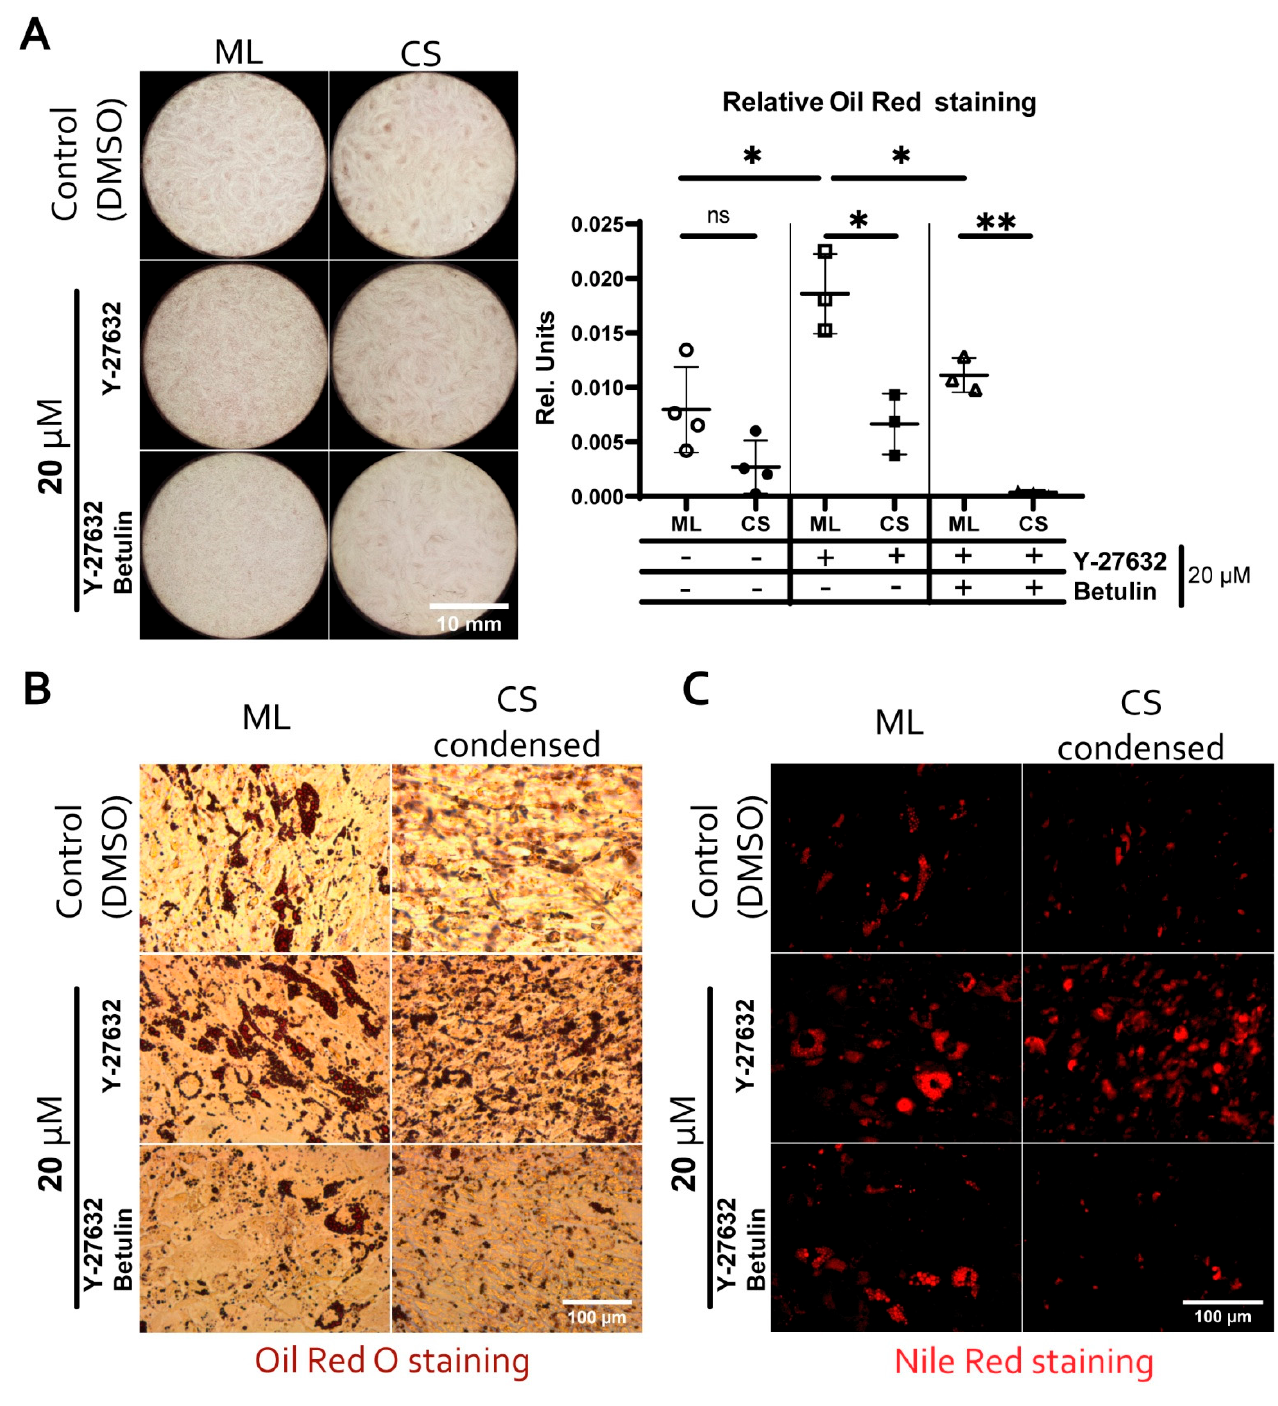
Figure 10. Lipid droplet accumulation during adipogenic differentiation is enhanced by the suppression of ROCK-1/2 pathway activity in the MSC monolayer culture but not in the total cell sheet (CS). Additional inhibition of SREBP abolishes this effect and suppresses lipid deposition in both the monolayer and whole CS. Lipid deposition in condensed areas, as well as in the monolayer, is enhanced by the suppression of ROCK-1/2 activity (Y-27632), while the inhibition of SREBP (betulin) abolishes this effect, reducing the lipid accumulation to a minimum. ( A ) MSC monolayer and CS overview at Day 18 of adipogenic differentiation with or without the addition of Y-27635 and betulin; Oil red O staining. Comparative analysis (right) of normalized Oil red O retention in lysates of cell cultures after differentiation. Oil Red O was eluted for the subsequent absorbance measurement; data was normalized to the DNA amount measured in the respective lysates of the cell cultures. ( B ) Higher magnification images of lipid droplets stained by Oil Red O in the monolayer and CS-condensed areas from the experiment in panel A ( A , C ). Light microscopy (brightfield), magnification 50×. ( C ). Lipid droplets stained by Nile Red in the monolayer and condensed areas under the experimental conditions similar